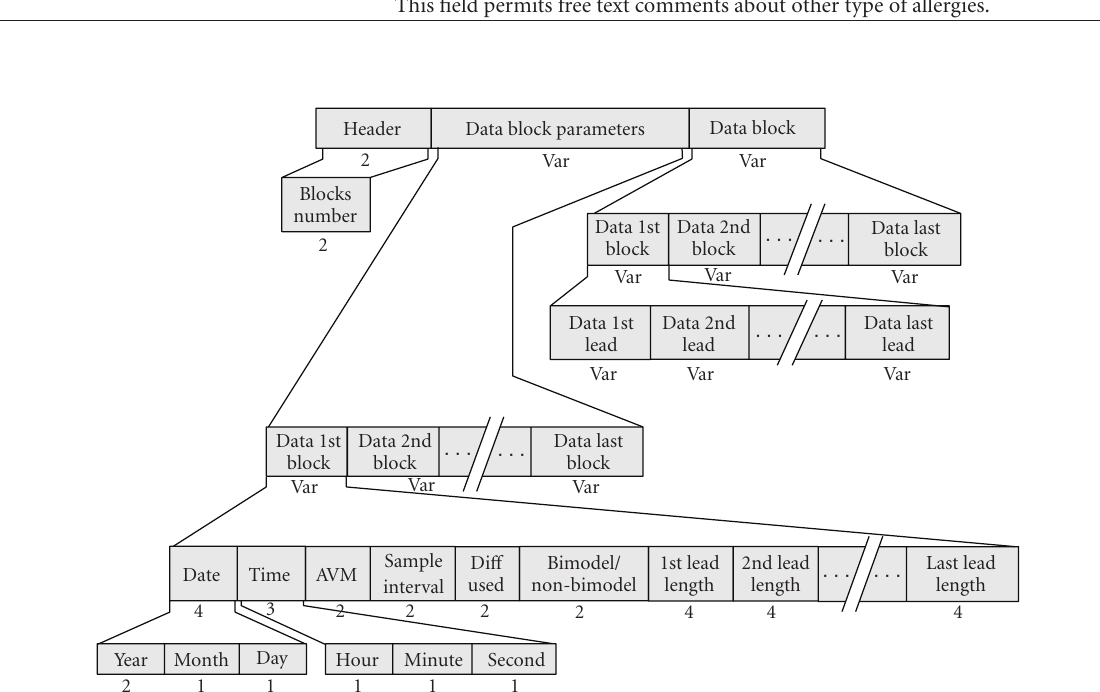
Figure 7: Overview of the data part holding the extended ECG data